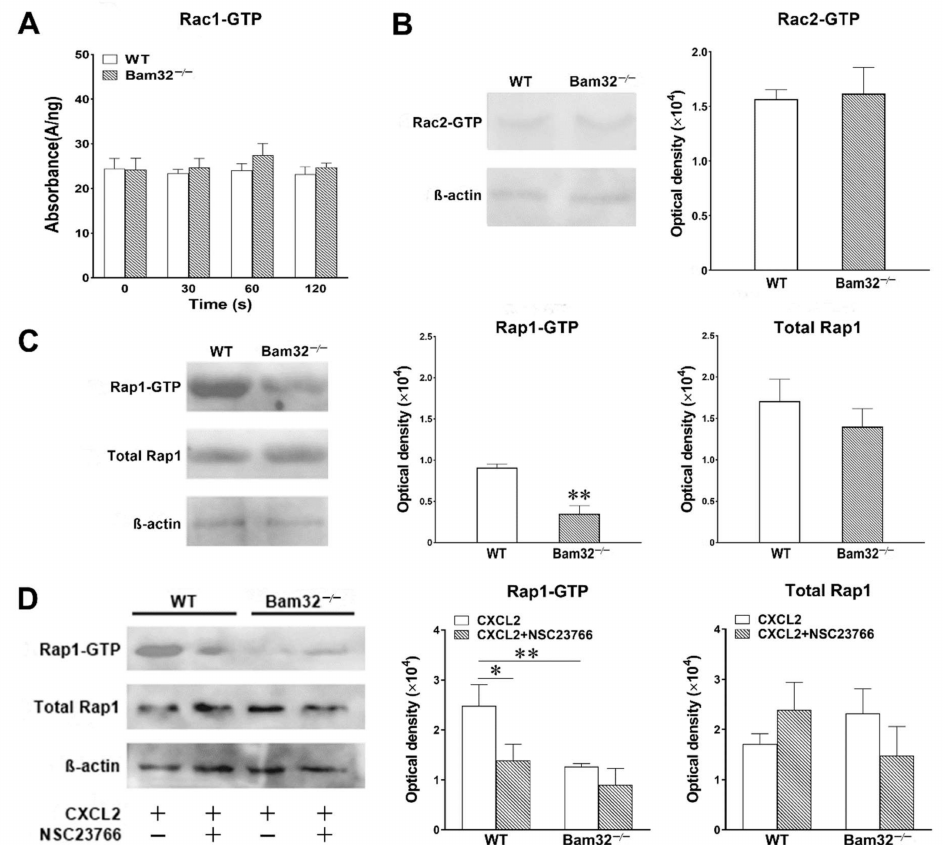
Figure 4. Effect of Bam32 deficiency on CXCL2-induced Rac1, Rac2, and Rap1 activation in neu- trophils. ( A ) Levels of Rac1-GTP in bone marrow-derived neutrophils from WT and Bam32 − / − mice with saline (0 s) and after the stimulation of neutrophils with CXCL2 (0.1 µ M) for 30, 60, and 120 s. ( B , C ) Representative original Western blots and the levels of Rac2-GTP ( B ) and Rap1-GTP ( C ) determined in bone marrow-derived neutrophils from WT and Bam32 − / − mice at 2 min after the stimulation of neutrophils with CXCL2 (0.1 µ M). ( D ) Representative original Western blots and the levels of Rap1-GTP and total Rap1 determined in bone marrow-derived neutrophils from WT and Bam32 − / − mice at 2 min after the stimulation of neutrophils with CXCL2 (0.1 µ M) and with pre-treatment with DMSO (vehicle) or Rac1 inhibitor NSC23766 (50 µ M) for 30 min and throughout the 2-min CXCL2 stimulation. ( A − D ): mean ± SEM of 3 samples per group. Each sample was individually collected and pooled from two mice of the same strain. The Rac1 G-LISA assay was performed twice in the 96-well plate. * and ** indicate significant differences ( p < 0.05 and p < 0.01, respectively) from WT mice ( C , D ) or from WT mice without